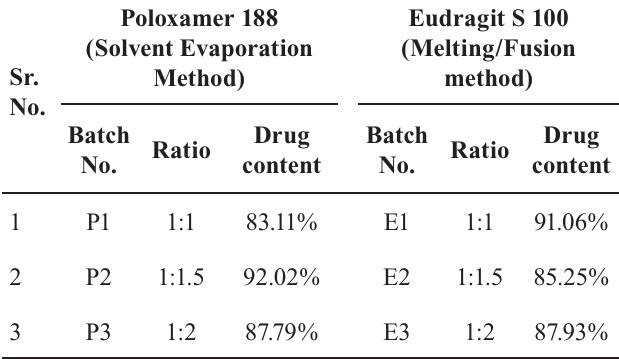
TABLE III - % Drug content of prepared solid dispersion